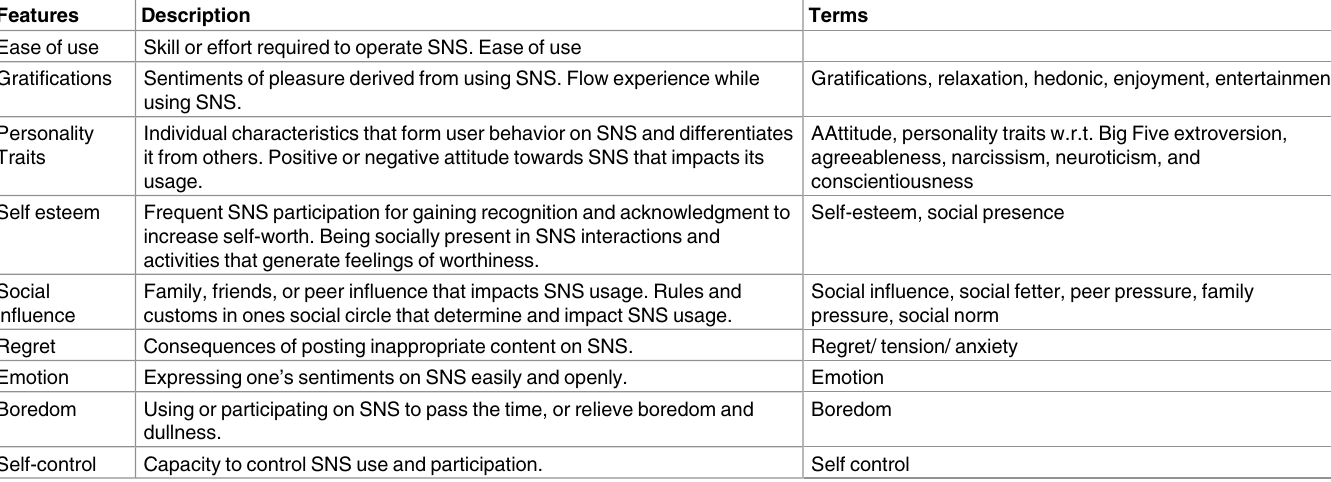
Table 12. Features having impact on user